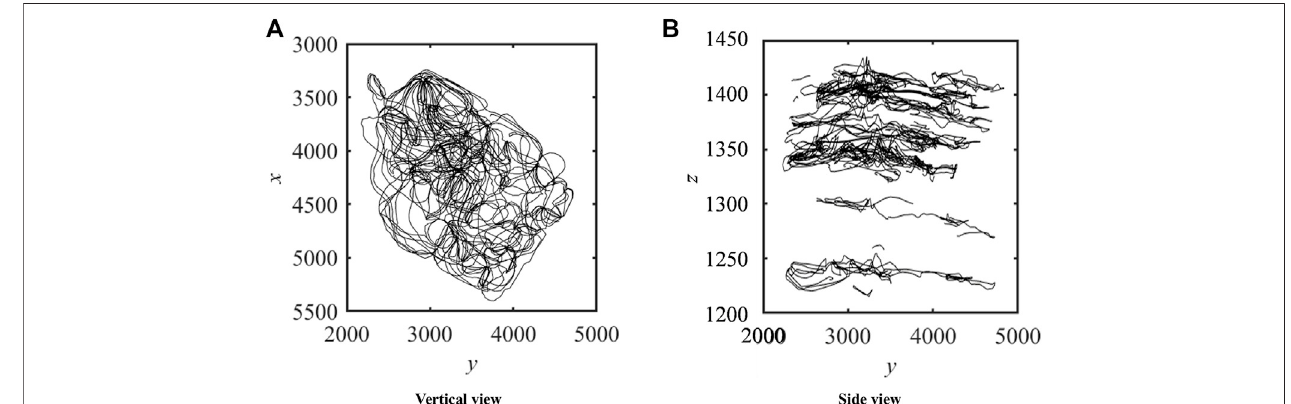
FIGURE 8 | The redrawn streamline fi